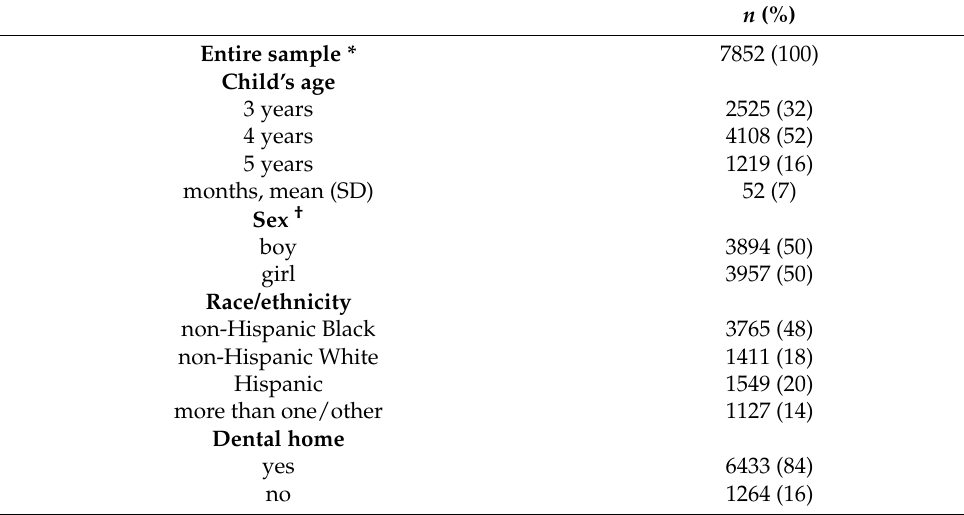
Table 1. Socio-demographic information of ZOE 2.0 study participants included in the analytical